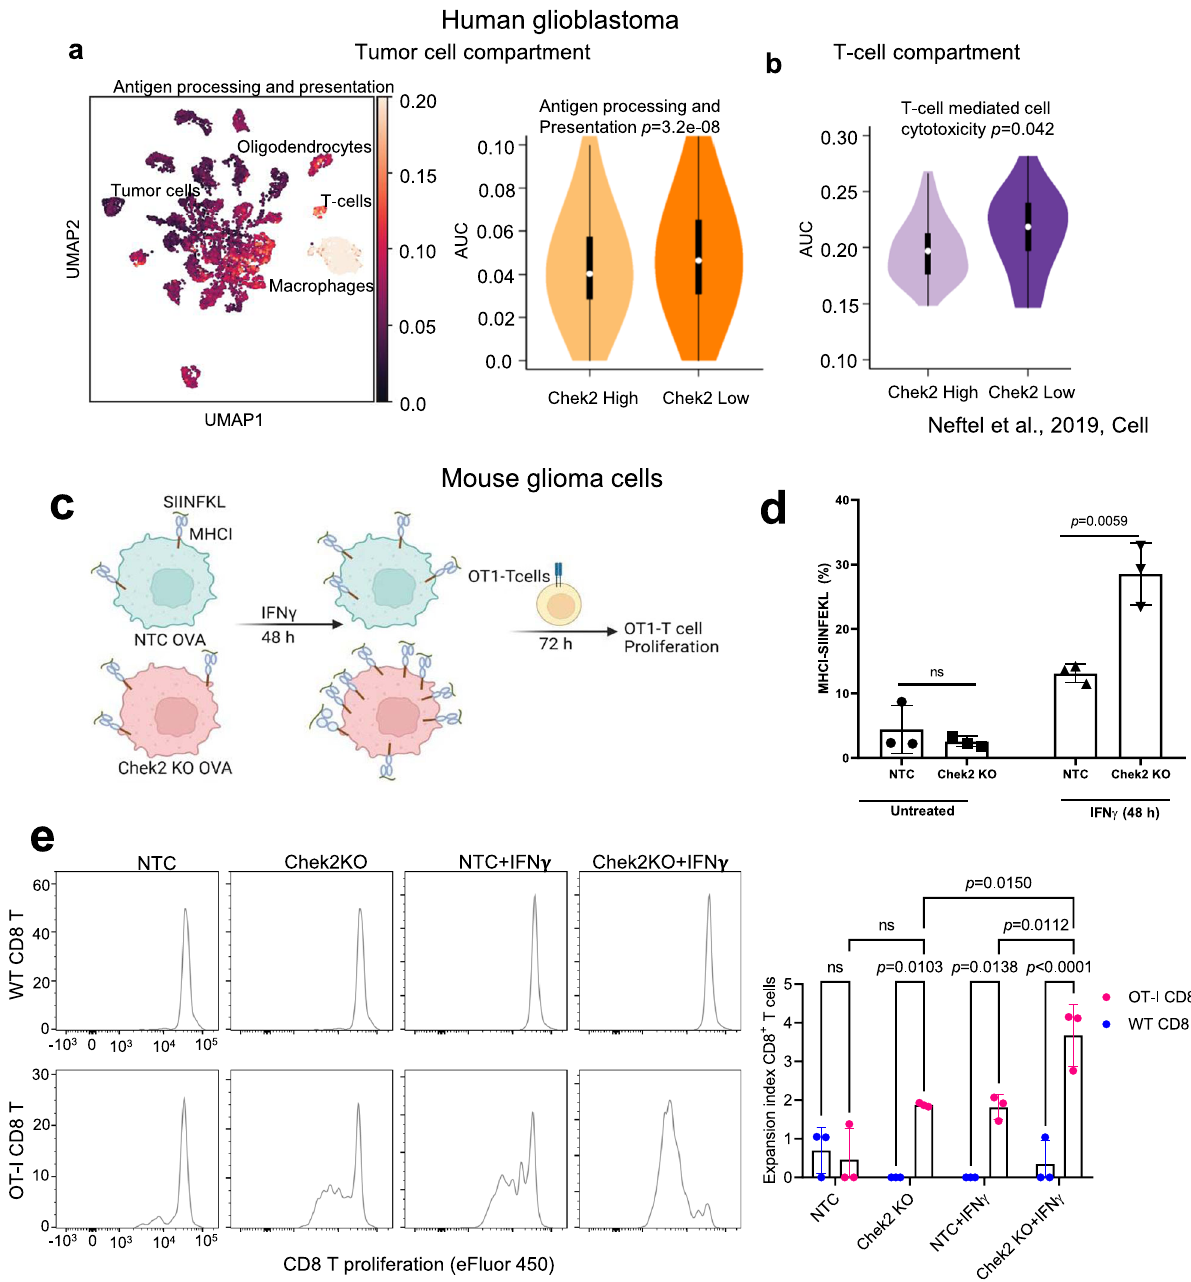
Fig. 4 | CHEK2 expression in tumor cells is inversely associated with enhanced antigen presentation on tumor cells, in human and mouse gliomas. a UMAP (left) and violin plot (right) of the gene signature scores of antigen processing and presentationpathwayin n =6,863tumorcellshighandlow CHEK2 expressionfrom 28humanglioblastomatumorsamples. b Violinplotofthegenesignaturescoresof T-cell-mediated cytotoxicity pathway in n =94 T cells from high CHEK2 vs low CHEK2 expressingsamples.ThescRNA-seqdatawasusedfromthestudypublished by Neftel et al. 28 . For ( a and b ), the p value represents two-tailed Mann – Whitney test; whiskers represent minimum and maximum values, the white dot inside the box represents the median and the box extends from the 25th to 75th percentiles. c Schematic showing the assay design to test the ability of Chek2 KO cells to promote OT-I CD8+ T-cell activation, assessed by cell proliferation (expansion index). d